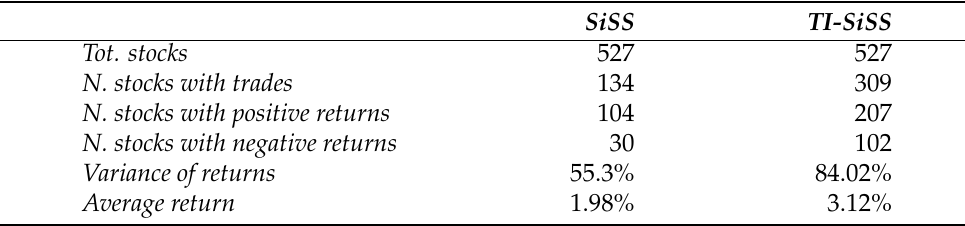
Table 6. TI-SiSS and SiSS results over the last